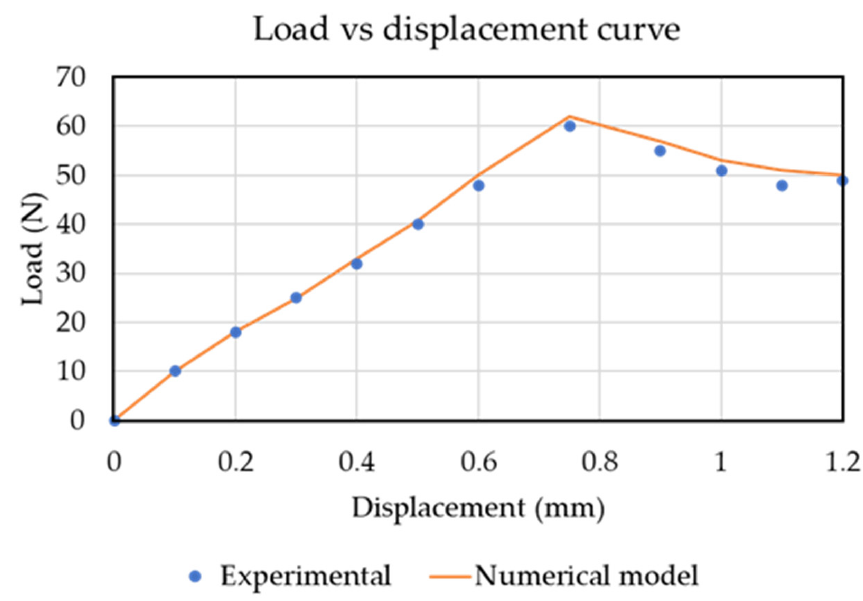
Figure 3. Load vs. displacement curve of the DCB specimen [26].